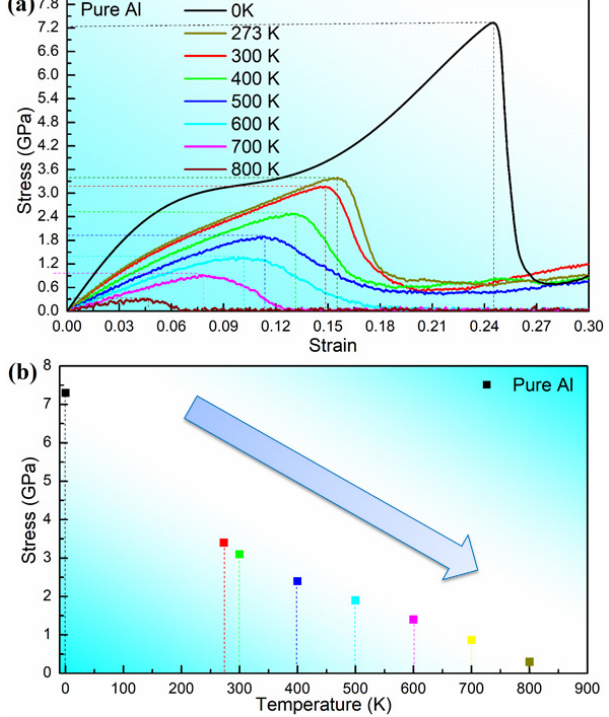
Figure 2. Stress–strain curves ( a ) and values ( b ) of perfect aluminum substrate at different temperatures.